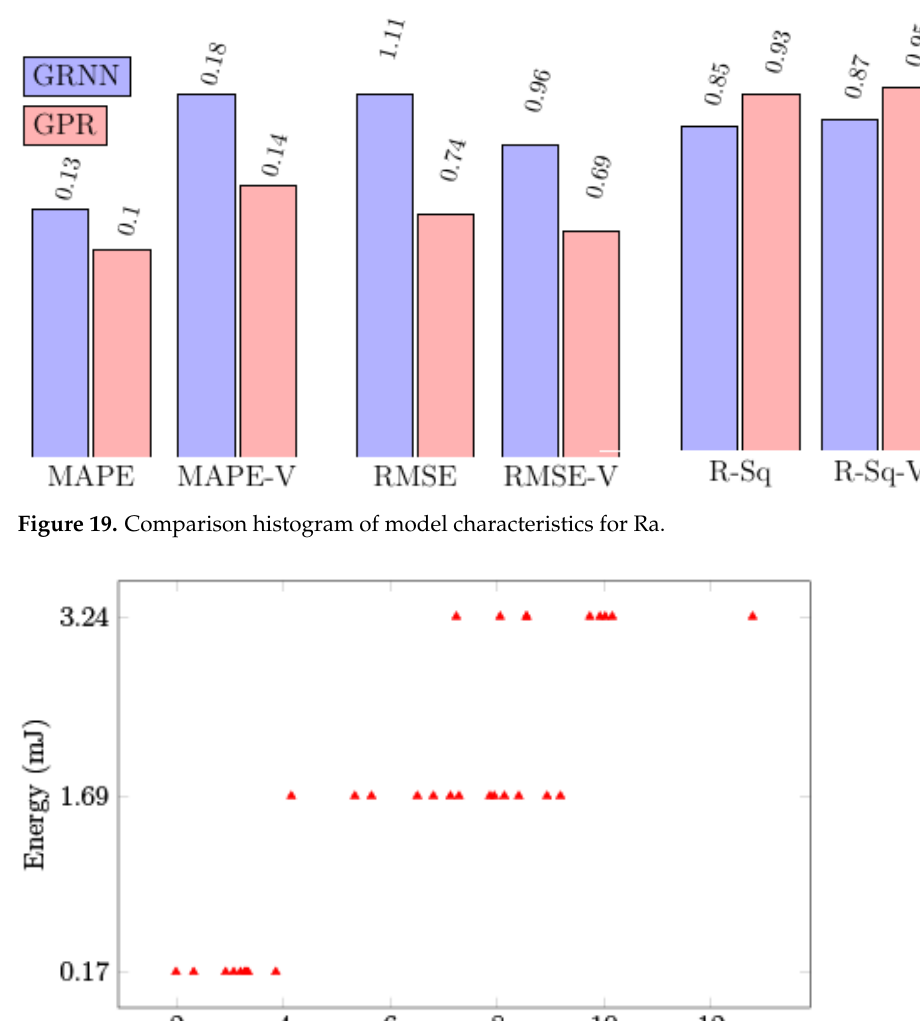
Figure 20. Experimental Ra data points stacked against energy.